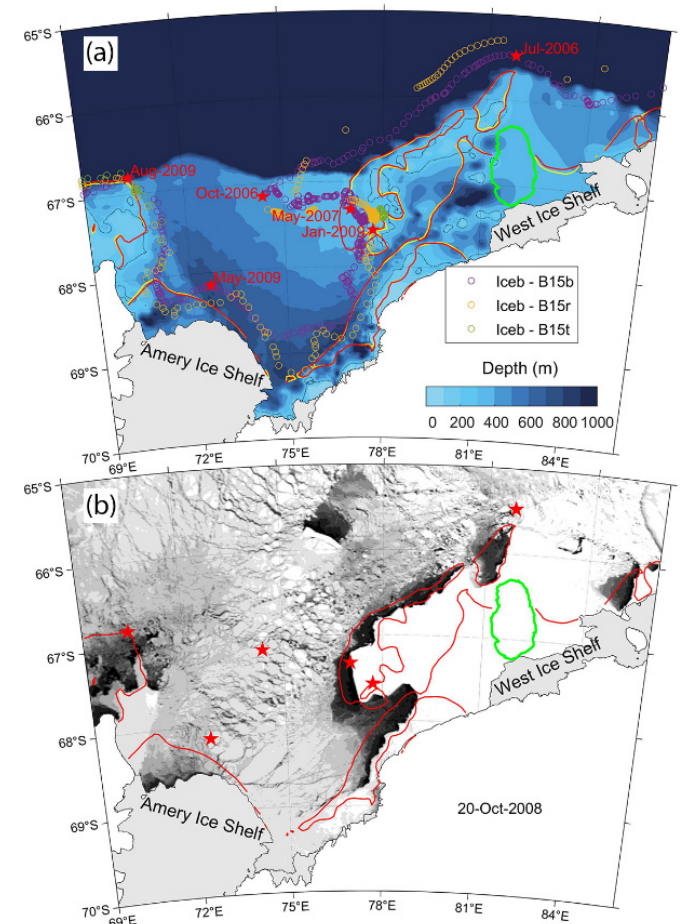
Figure 11. ( a ) The tracks of icebergs B15b, B15r, and B15t in the giant iceberg group, shown by the purple, yellow, and light green circles, respectively. The red stars indicate the positions of iceberg B15b at certain times. The red lines indicate the POF = 24% contour line in the winters of 2002 to 2011, and the yellow line indicates the POF = 24% contour line in the winters from 2002 to 2011, except for 2007 and 2008. The green line indicates the outline of iceberg D15. ( b ) MODIS Visible image taken on 20 October 2008. The lines and symbols have the same meanings as in ( a ).